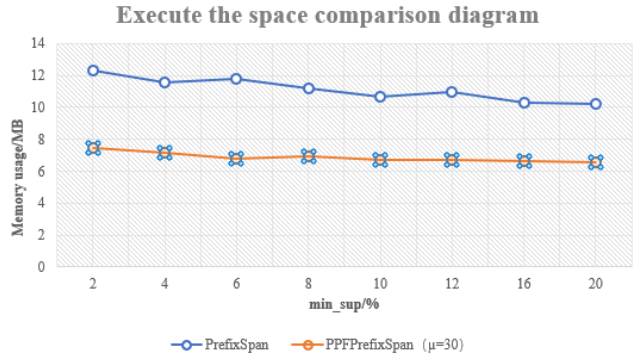
Fig. 2. Comparison diagram of execution